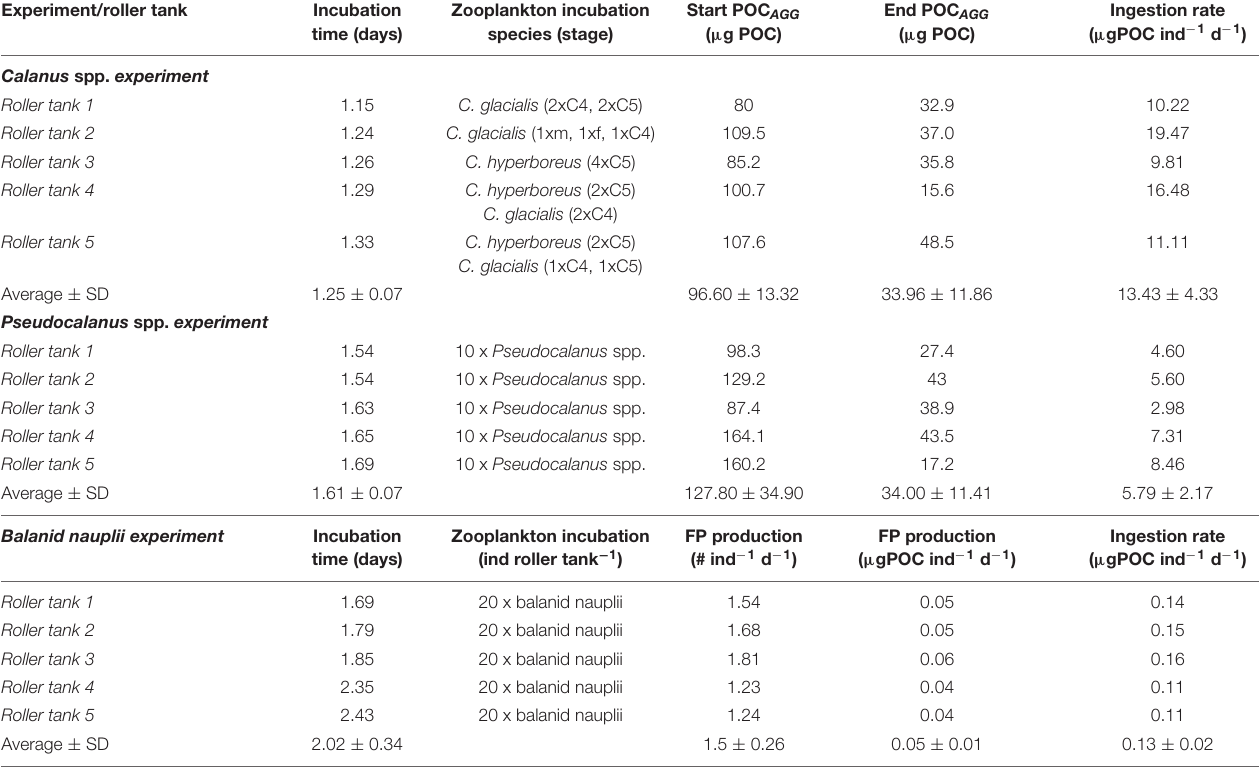
TABLE 3 | Overview of the three grazing incubations; Calanus spp. experiment, Pseudocalanus spp. experiment, and balanid nauplii experiment. Experiment/roller